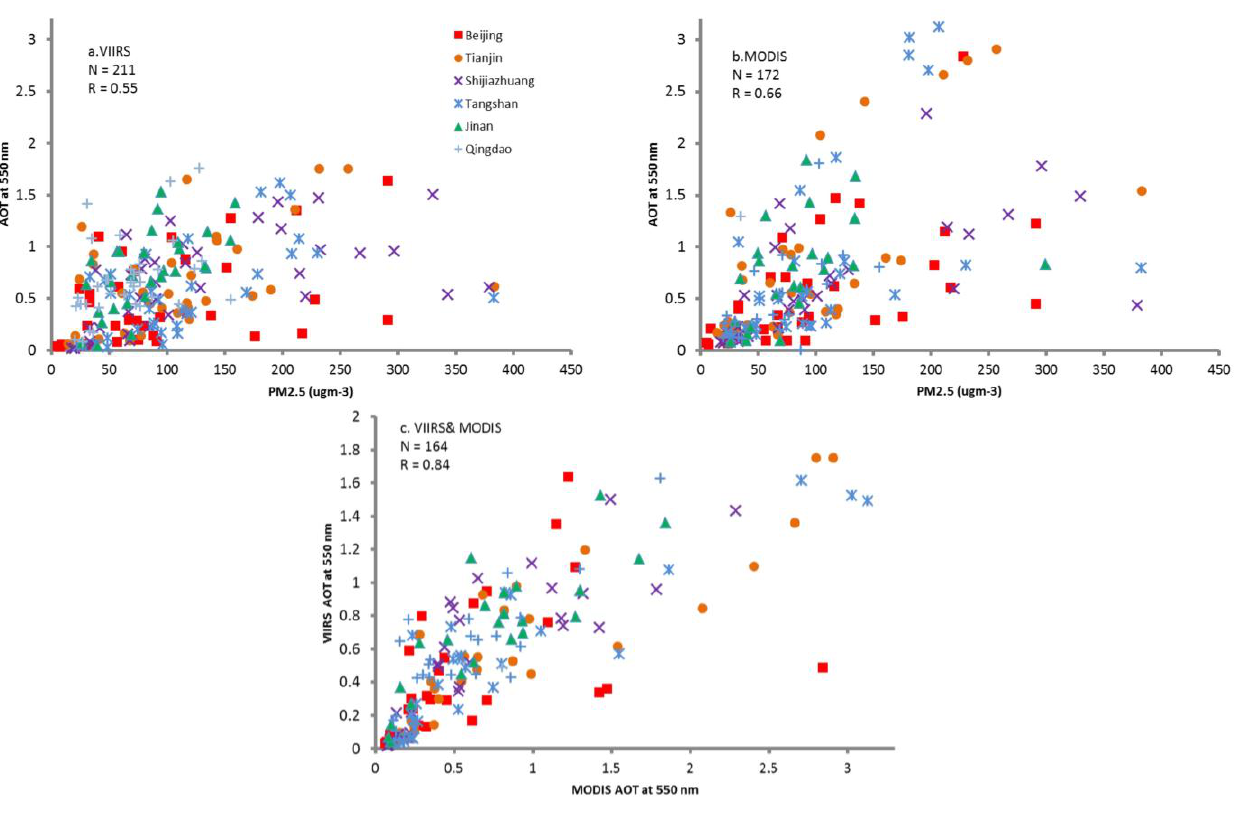
Figure 3. Scatter plots of mean AOT and ground PM 2.5 (18 October–30 November, 2014) for the six cities ( a ) VIIRS AOT and ground PM 2.5 ; ( b ) MODIS AOT and ground PM 2.5 ; ( c ) VIIRS AOT and MODIS